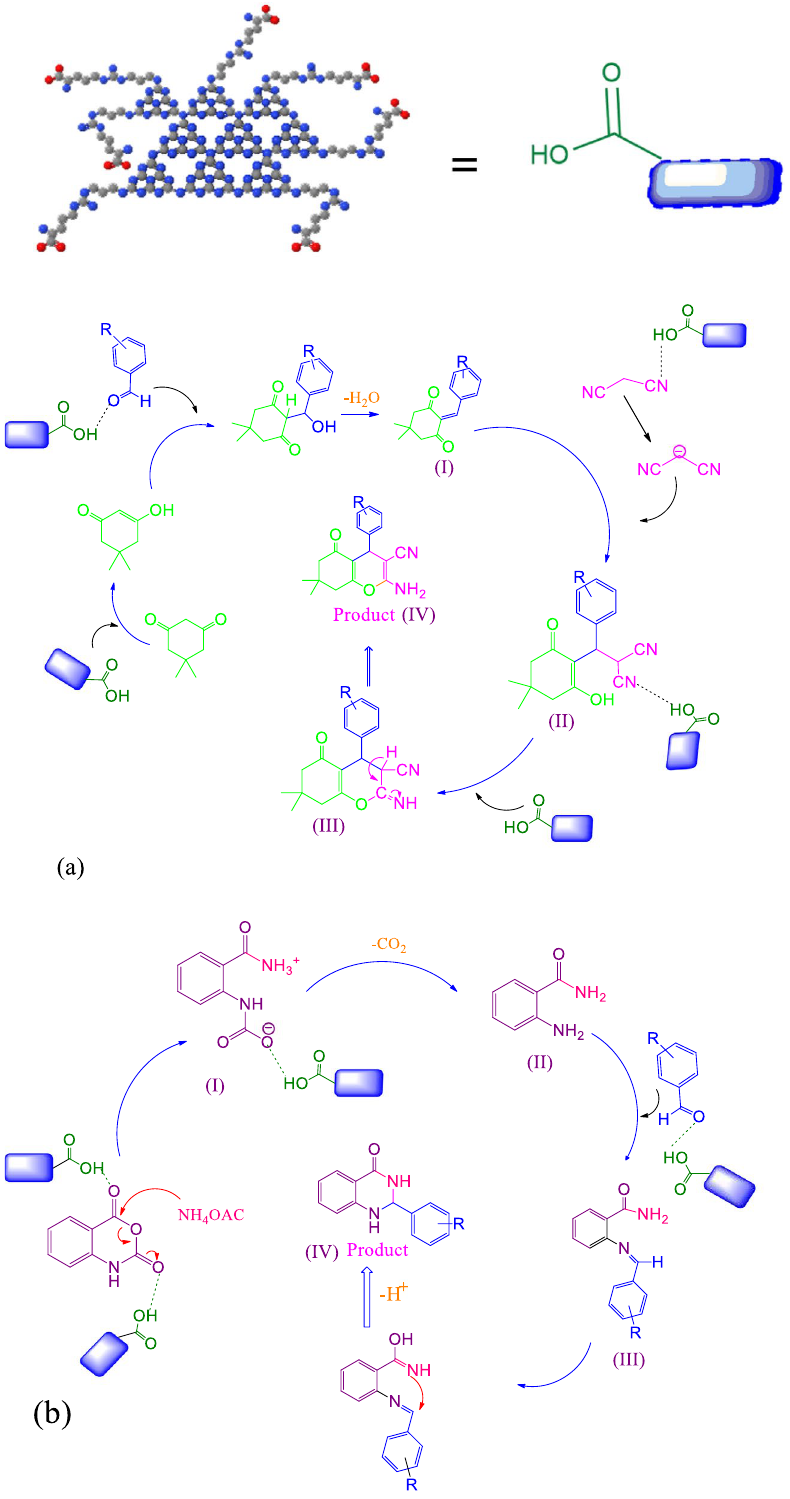
Figure 10. Proposed mechanism for synthesis of 4 H -chromene derivatives ( a ), 2,3-dihydro quinazoline ( b ), and 1,4-dihydropyridine ( c ) by using g-C 3 N 4